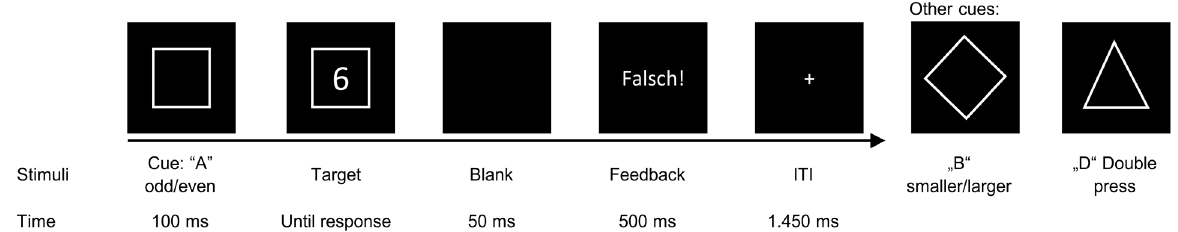
Figure 2. The outline of the backward inhibition paradigm including the experimental logic is presented. Each trial begins with the presentation of a cue in the center of the screen. Cue “A” is a square and indicates to decide whether the target is odd or even. Cue “B” is a diamond and indicates to decide whether the target is smaller or larger than 5. Cue “D” is a triangle and indicates a double-press regardless of the target. After 100 ms, the target stimulus is presented within the cue stimulus until a response is made. During the inter-trial-interval (ITI) of 2.000 ms, there is feedback of 500 ms for incorrect trials with the German word “Falsch!” (English: “Incorrect!”). There is no feedback in correct trials.